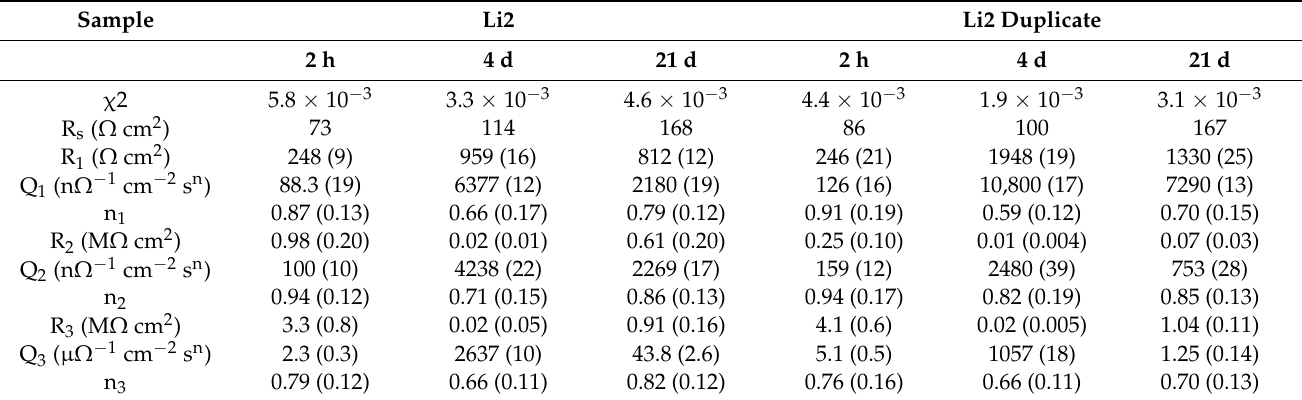
Figure 9. Bode plots of the scratched ( a ) Li2 coating and ( b ) Li2 duplicate coating after 2 h, 4 days, 7 days, and 21 days exposure to 3.5% NaCl solution; ( c ) electrical equivalent circuit (EEC) used to fit the EIS data (black lines), and ( d ) cross-sectional scheme of the self-healing activity induced by lithium ions in the defect of the coating. Table 3. Electrochemical parameters obtained by fitting EIS data using the EEC of Figure 8c for the scratched Li2 coatings in duplicate after 2 h, 4 days, and 21 days of exposure to NaCl 3.5% solution. The values in brackets correspond to the error (%) of each